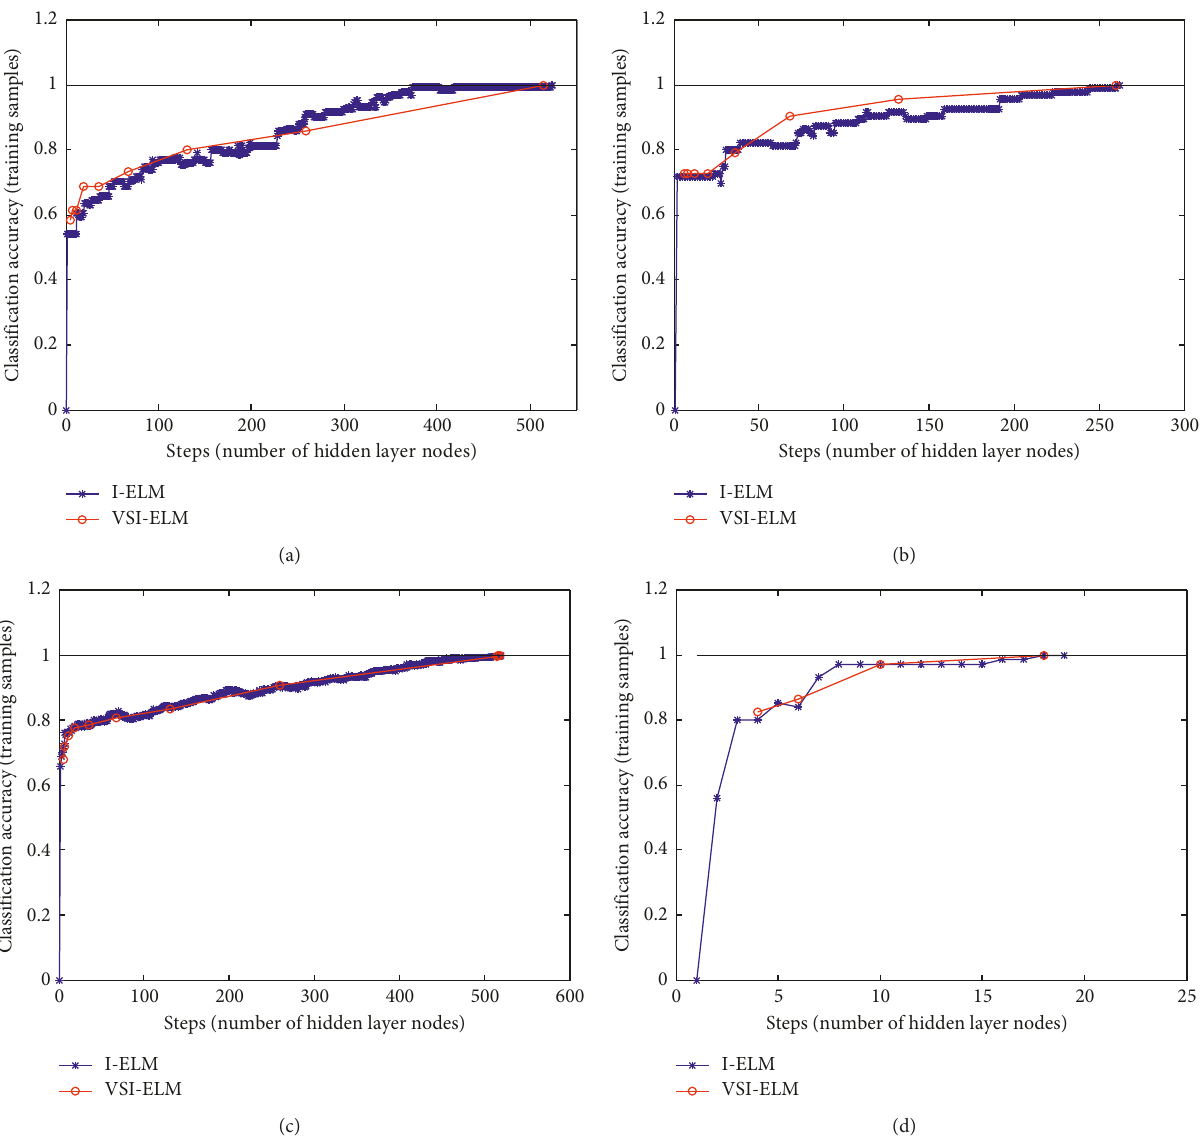
Figure 5: Classification accuracy updating curves of training samples of VSI-ELM and I-ELM: (a) statlog (heart); (b) parkinsons; (c) diabetes; (d) iris.